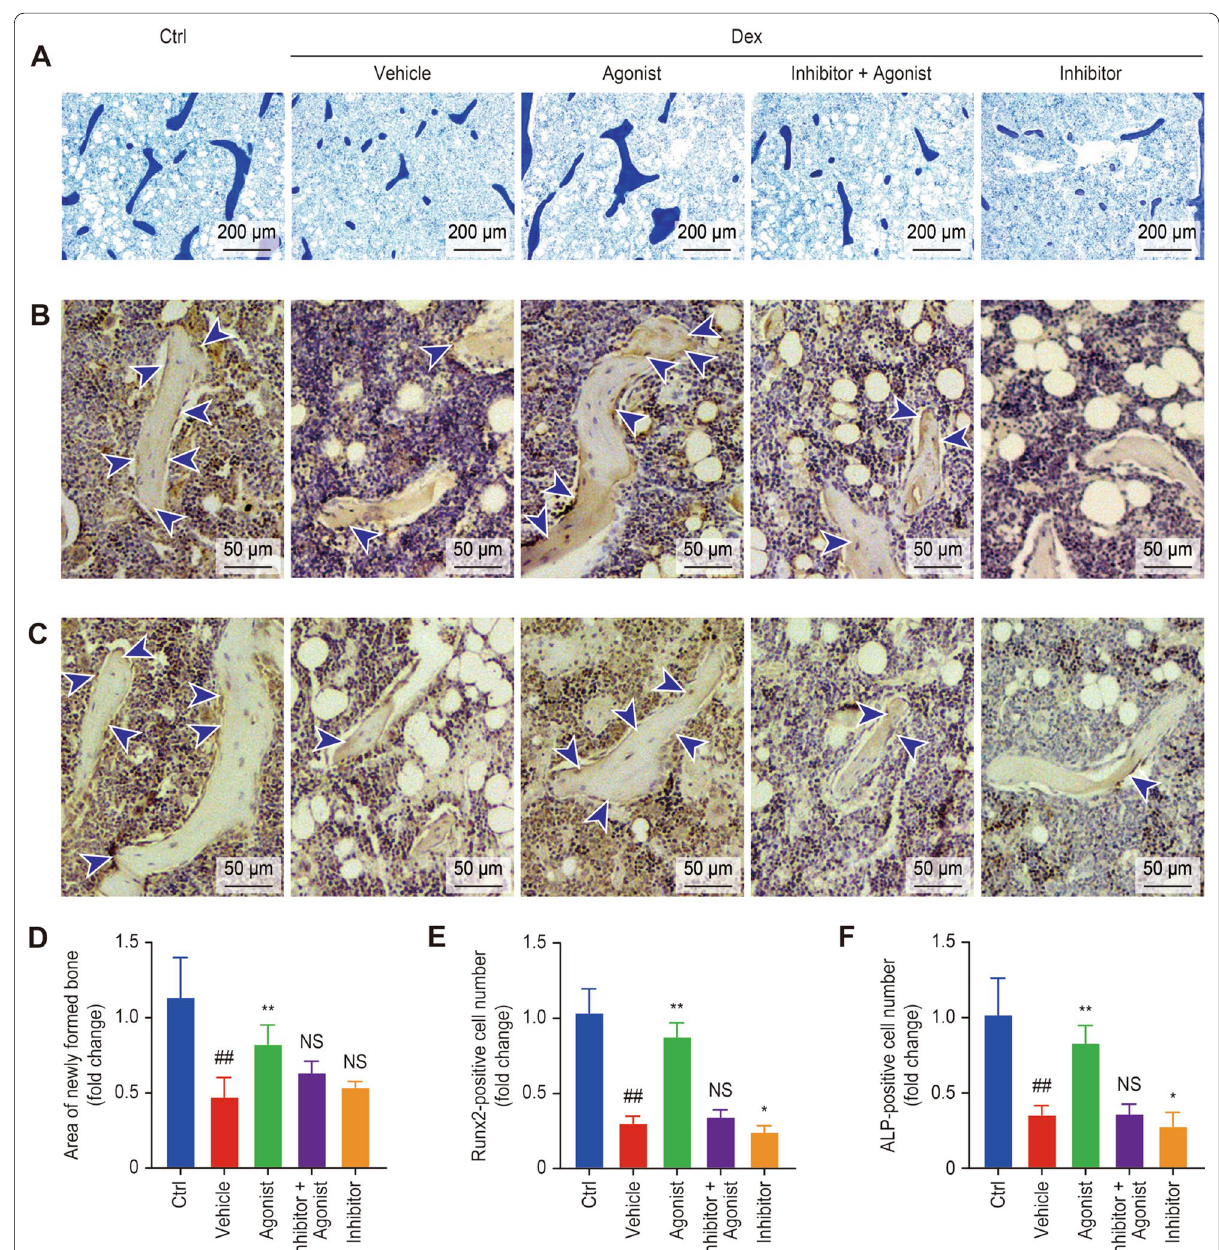
Fig. 7 Activation of D1R promoted bone formation in vivo. A Representative images of toluidine blue staining. B and C Representative images showing IHC staining of Runx2 and ALP. D Quantitative analysis of the area of newly formed bone calculated by toluidine blue staining. E and F Quantitative analysis of the number of positive cells stained with Runx2 and ALP were analyzed by IHC staining, n significant, * p < 0.05, ** p < 0.01, vs. the vehicle group, # p < 0.05, ## p < 0.01, vs. the control